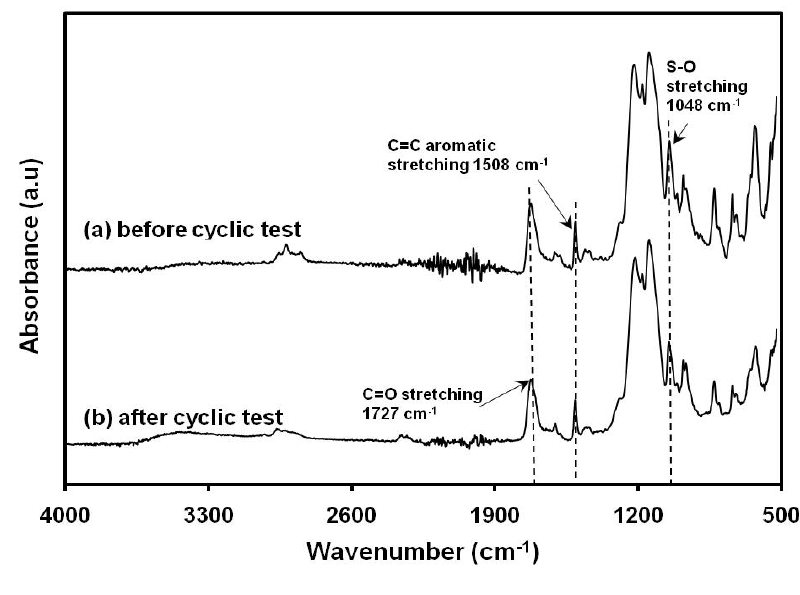
Figure 14. FTIR spectra of 90/10 Nafion/HBPEAc-COOH ( a ) before and ( b ) after subjected to the cyclic AC impedance proton fuel cell measurements for a total of 160 h. These spectra were obtained at room